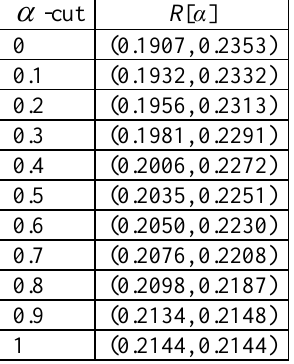
Table 2. Fuzzy reliability of the reliability